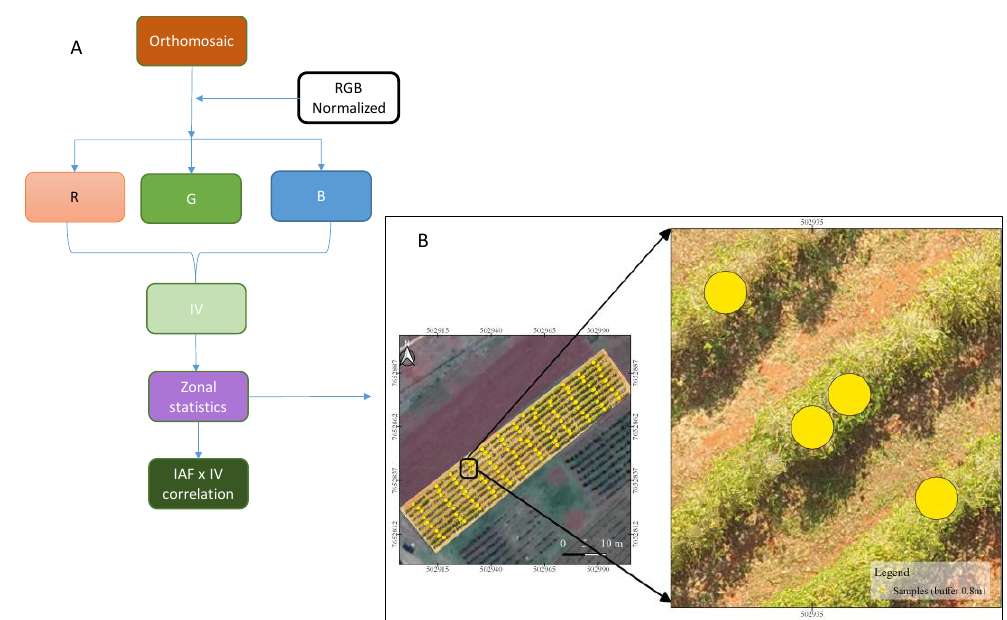
Figure 2. Flowchart for calculating the VI and correlation with LAI ( A ). Buffer of 0.8 m to calculate the mean value of VI in each sample ( B ).